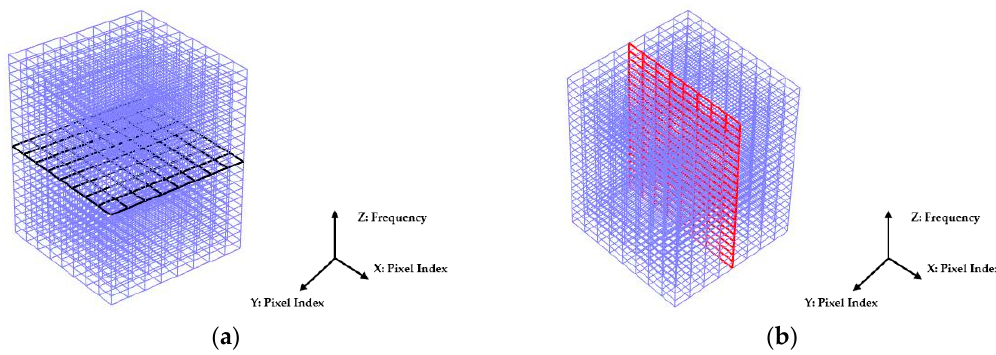
Figure 9. Spectral cuboid: 2D images obtained with multi-frequency. ( a ) Horizontal cross-section represents the 2D image at one frequency. ( b ) Vertical cross-section represents the spectral images of selected pixels.